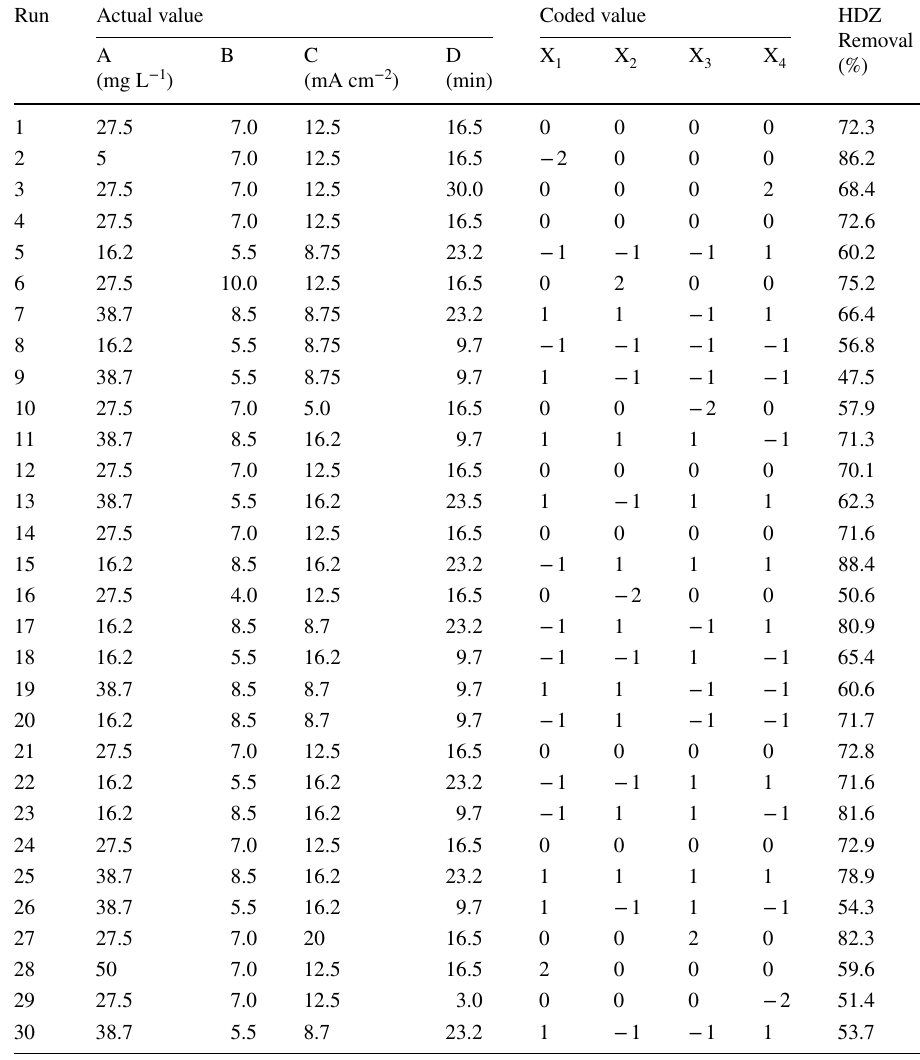
Table 2 The designed experiments and values of HDZ removal efficiency as the response